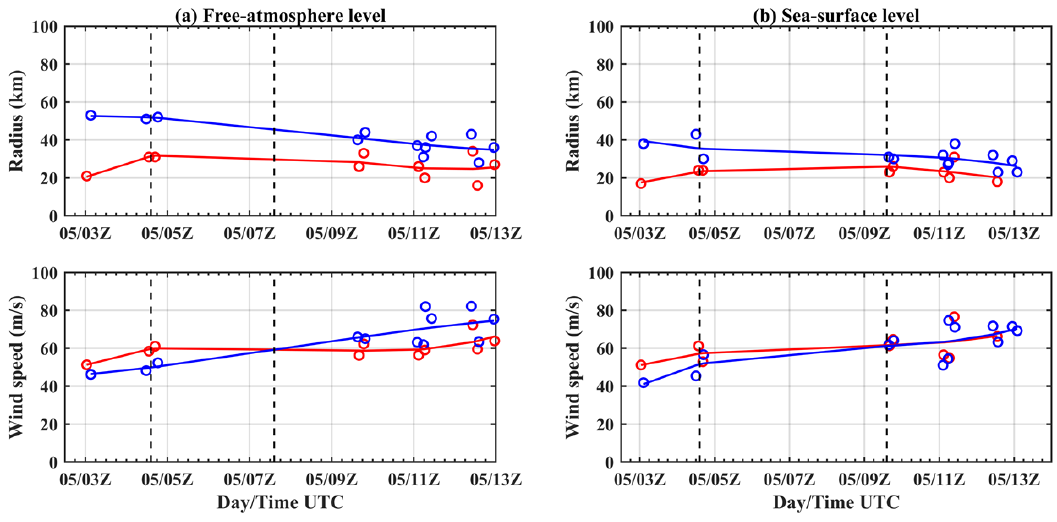
Figure 7. The same as Figure 6 but for the ERC02 event.